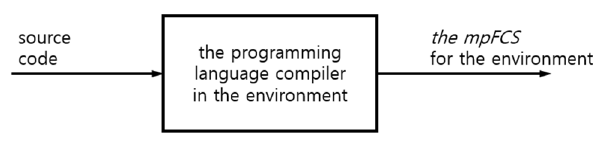
Figure 15. The deploying process of the mpFCS into any environment.